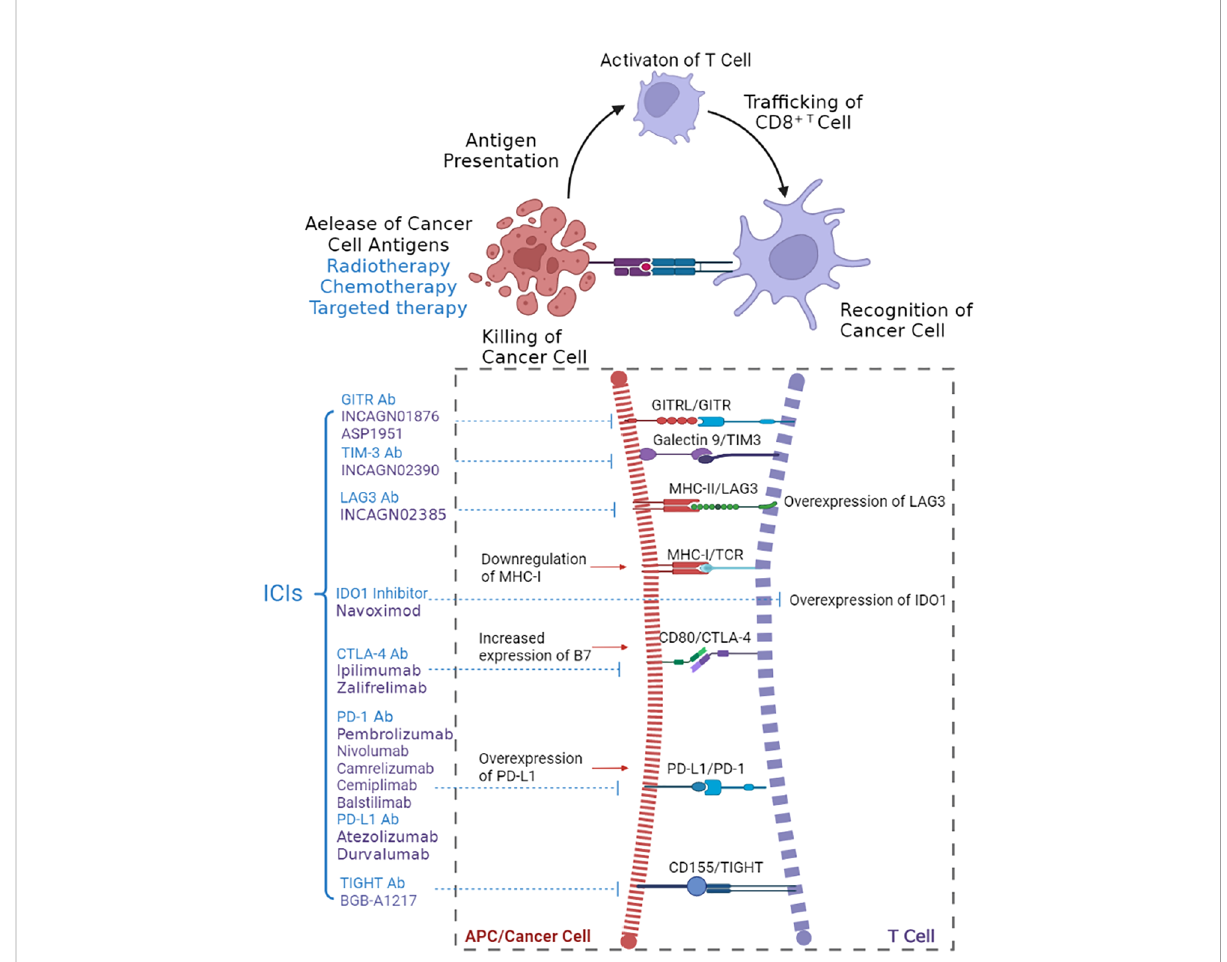
FIGURE 1 Mechanism of action of ICIs in the anticancer immune response. Created with ©